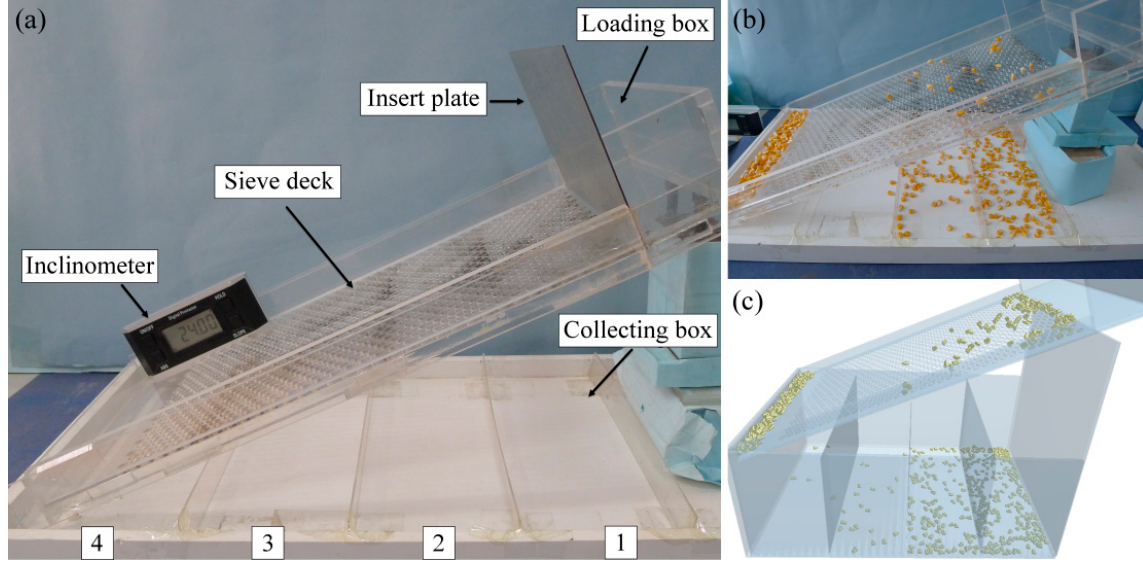
Figure 16. Schematic of the “self-flow screening” test: ( a ) apparatus of the “self-flow screening” test, ( b ) experimental result of the “self-flow screening” test and ( c ) simulation result of the “self-flow screening” test.